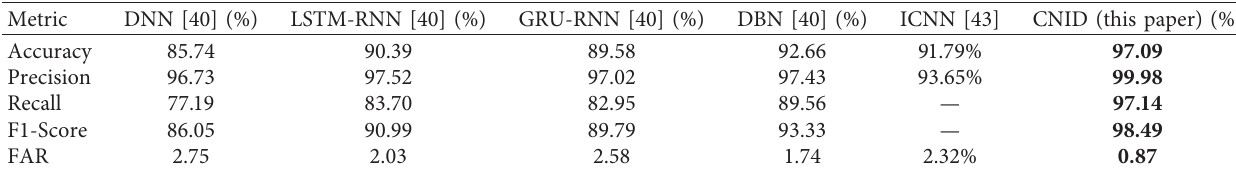
Table 5: NSL-KDD experiment